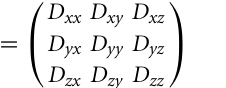
finite N d . (D) The tensor can be rotated to match the principal direction of diffusion, i.e., in white matter, the first eigenvector ( ε 1 ) matches the predominant fiber tract orientation; thus, the largest eigenvalue ( λ 1 , known as “axial diffusivity”) quantifies water mobility along this orientation. Analogously, ε 2 and ε 3 define the plane perpendicular to the axonal arrangement so that λ 2 and λ 3 can be averaged as a “radial diffusivity” (RD). In addition, all three eigenvalues can be averaged to estimate the “mean square displacement” of water molecules—that is, the “mean diffusivity”